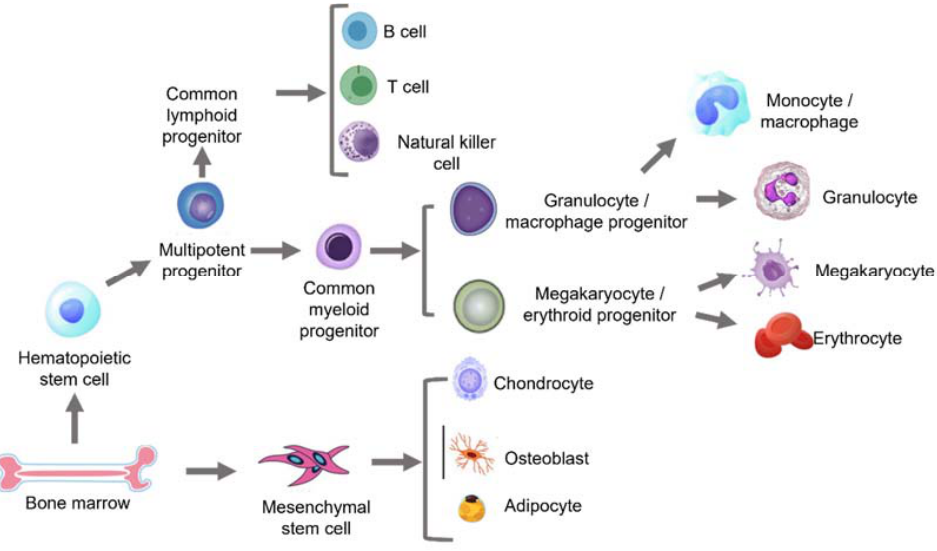
Figure 2. An overview of the lineages arising from the HSC and MSC populations.